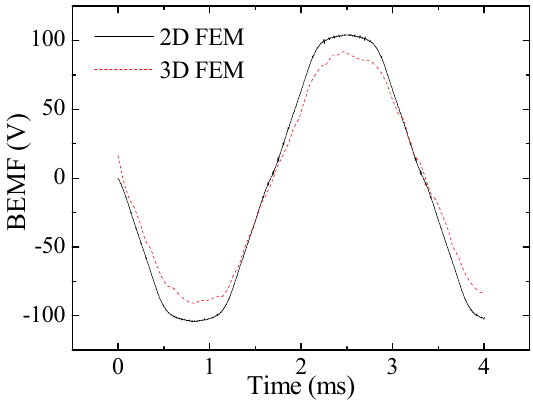
Figure 15. BEMF from 2D and 3D FEM.